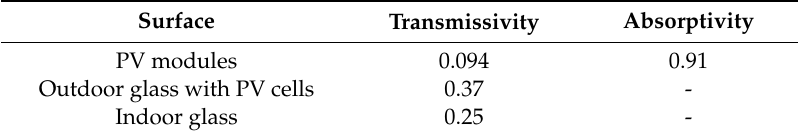
Table 4. Radiative properties measured in the